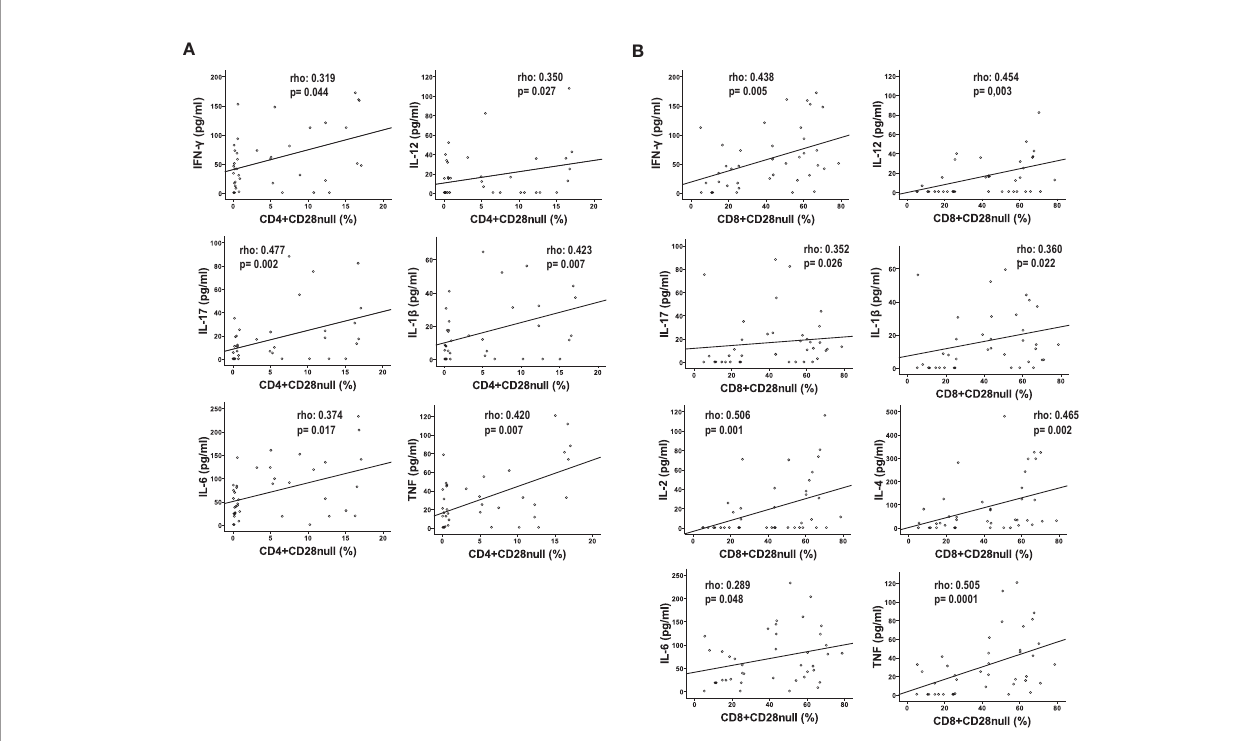
FIGURE 4 | Levels of cytokines correlated to CD28null T-lymphocyte populations in CHF patients. Levels of cytokines (pg/mL) in CD4+ (A) and CD8+ T-lymphocytes (B) . Spearman ’ s test was applied to calculate the correlations; the p-value and coef fi cient of correlation are listed on the